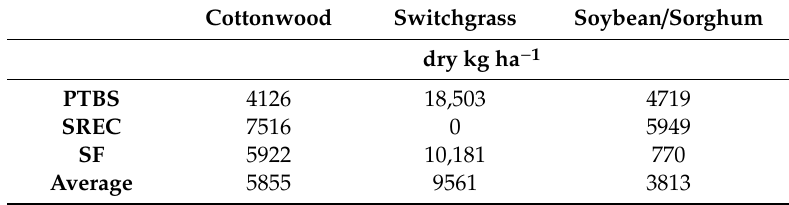
Table 1. Amount of harvested biomass in all three sites during three years of